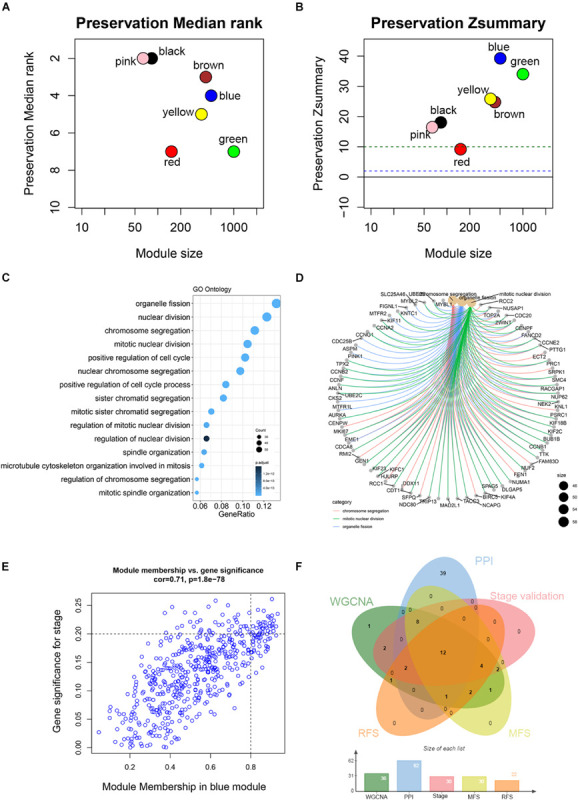
Module preservation analysis and functional enrichment of clinically significant module. (A) The medianRank statistics of the module preservation using independent dataset GSE21653. The medianRank of the modules close to zero indicates a high degree of module preservation. (B) The Zsummary statistics of the module preservation using independent dataset GSE21653. These horizontal lines represent the Zsummary threshold (Z = 2 and Z = 10), which is used to indicate strong evidence of preservation (above 10) and low to moderate preservation (above 2). (C) Biological processes of genes in the blue module. The x-axis is the gene ratio, which is the ratio of enriched genes to the total number of genes in the term. (D) The three top-ranked biological processes and the corresponding genes of the blue module. (E) Scatter plot shows the gene module membership and gene significance of the blue module. (F) Common genes with statistical significance in different methods, including survival, one-way ANOVA, Pearson’s correlation, and co-expression analysis.